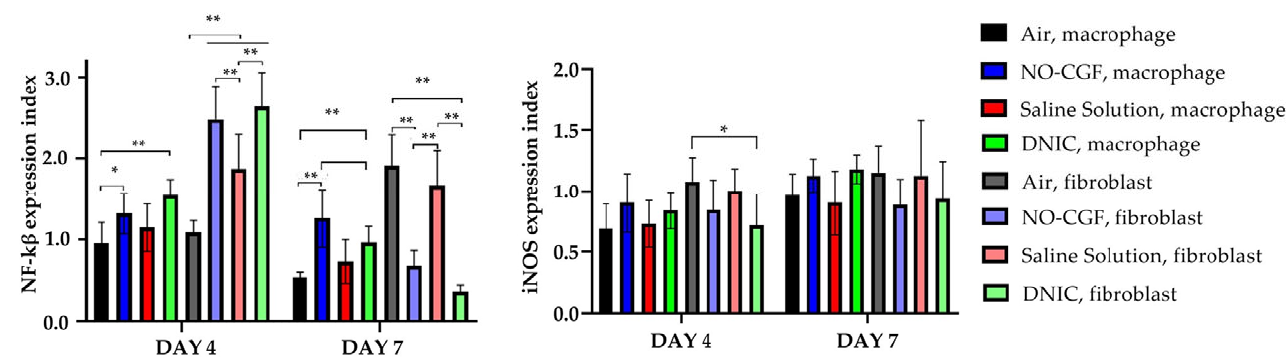
Figure 7. Activity index of NF- κ ß and iNOS. Two-way ANOVA, median ± 95% CI. *— p < 0.05, **— p < 0.01.